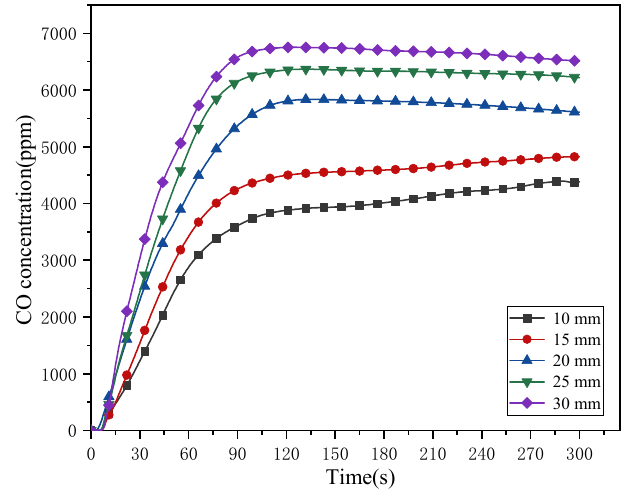
Figure 13. The CO concentration in transition room with 4 mm hole diameters.